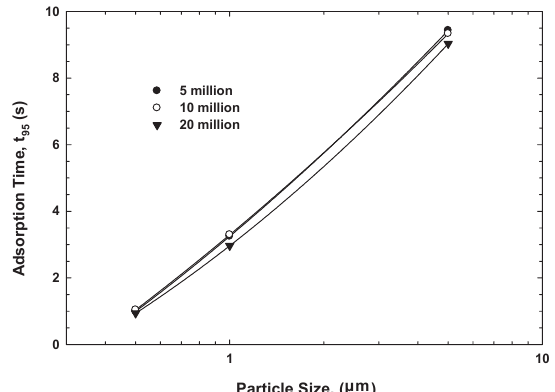
Fig. 1 The effect of particle size on theoretical adsorp- tion times at a slurry concentration of 1% by vol- ume and a mean shear rate of 100 s -1 .